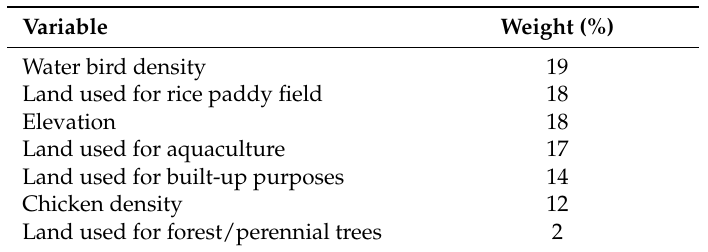
Table 2. Estimated weight of each factor to the HPAI H5N1 occurrences.